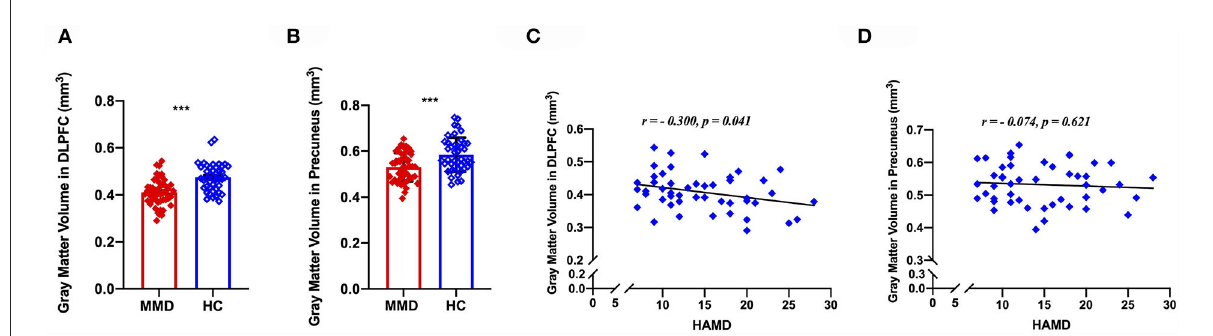
FIGURE4 Voxel-based morphology comparison between MMD patients and HCs, and correlations between the reduction volumes and depression symptoms. The gray matter volume of DLPFC was significantly smaller in MMD patients than in HCs (A) , meanwhile, the gray matter volume of precuneus was significantly smaller in MMD patients than in HCs (B) . Scatter plots indicating that the gray matter volume of DLPFC was negatively correlated with HAMD scores in MMD patients (C) , whereas the gray matter volume of precuneus was not correlated with HAMD scores in MMD patients (D) . DLPFC, dorsolateral prefrontal cortex; MMD, mild-to-moderate depression; HCs, healthy control. ***, p < 0.001.